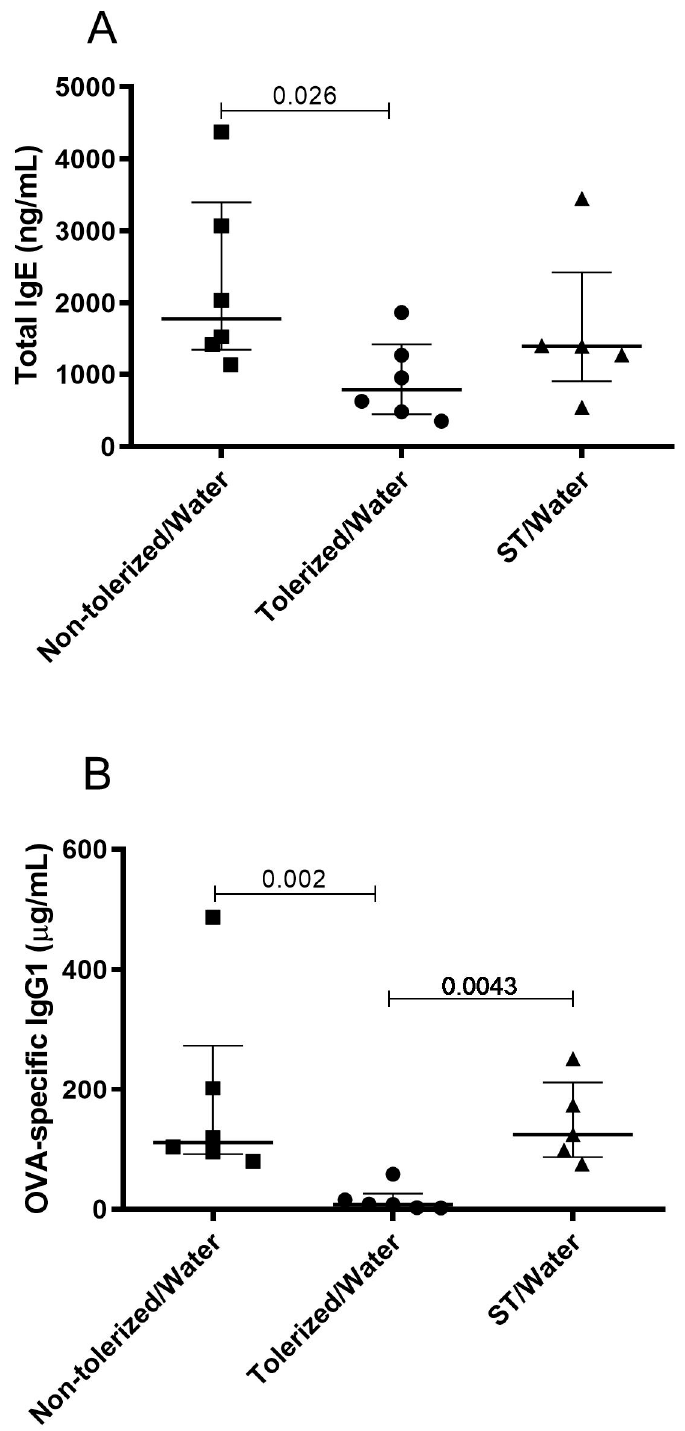
Figure 3. Total IgE ( A ) and OVA-specific IgG1 ( B ) levels in 5-week-old mice subjected to a food allergy protocol. Mice received PBS using a gavage on days 6, 7, and 8 (non-tolerized / water), OVA (10 mg / mL) ad libitum from day 4 to day 8 (tolerized / water), or a sub-tolerogenic dose of OVA (0.5 mg) using a gavage on days 6, 7, and 8 (ST / water). Values represent the median ± interquartile range of six mice for the non-tolerized / water and tolerized / water groups and of five mice for the three ST / water groups. The significant p -values ( ≤ 0.05) are shown on the graphs.